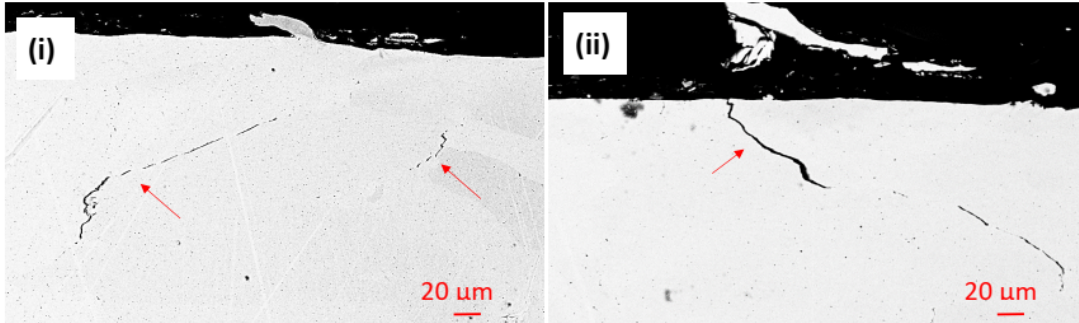
Figure 12. Cracks were observed in ( i ) the bulk and ( ii ) at the surface of the Al-HEA coating in the aerated testing.